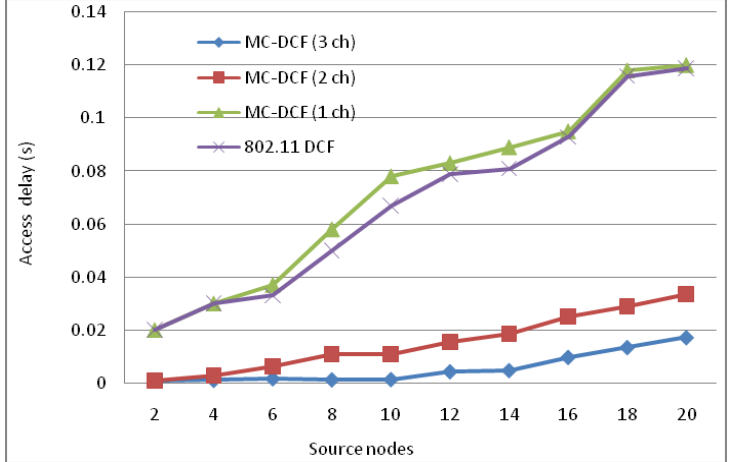
Figure 16. Delay impact from source nodes when using multiple sinks with multiple radio